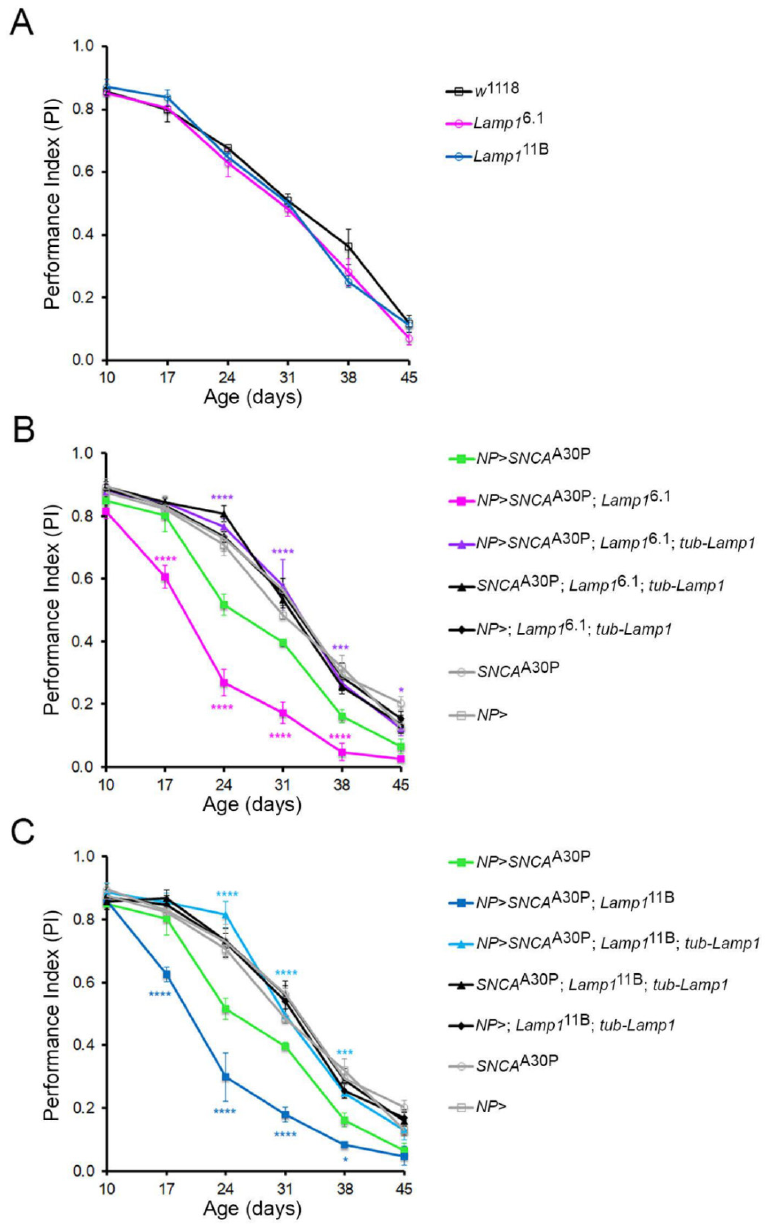
Figure 2. Loss of Lamp1 enhances locomotion defects in the α -synA30P-PAM Drosophila PD model. ( A ) The climbing performance of homozygous Lamp1 6.1 and Lamp1 11B mutant flies is not different from w 1118 control flies throughout life. However, the presence of homozygous Lamp1 6.1 ( B ) and Lamp1 11B ( C ) mutations significantly worsened the climbing performance of flies overexpressing SNCA A30P in PAM dopaminergic neurons using NP6510-Gal4 ( NP ) over the lifespan of the flies. The co-expression of ubiquitously expressed tub - Lamp1 fully suppressed the deleterious effect of SNCA A30P expression in the Lamp1 mutant backgrounds. Two-way ANOVAs with Dunnett’s post-hoc test for multiple comparisons (**** p < 0.0001; *** p < 0.001; * p < 0.05). Error bars represent SEM. 2.3. The Level of Neuronally-Expressed α -SynA30P Is Decreased in Lamp1 Mutant